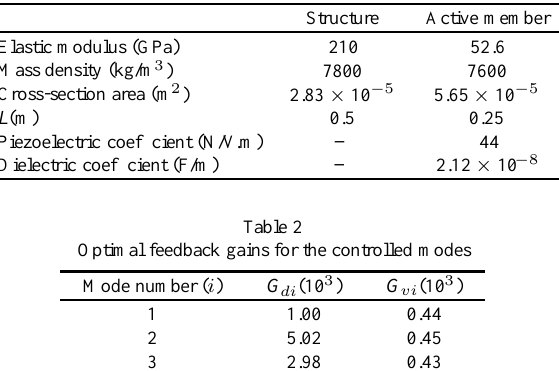
Table 1 Material properties and dimensions of the smart truss structure